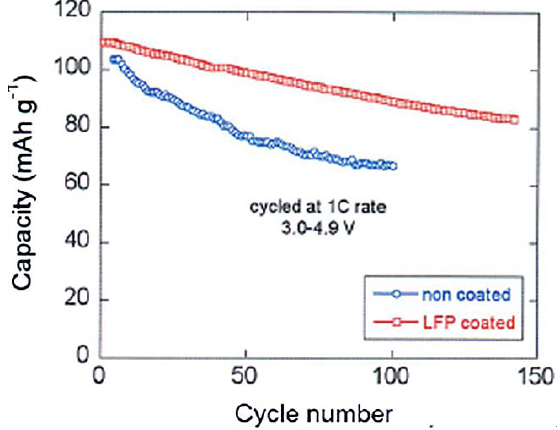
Ni O and Li/LiFePO 1.5 0.5 4